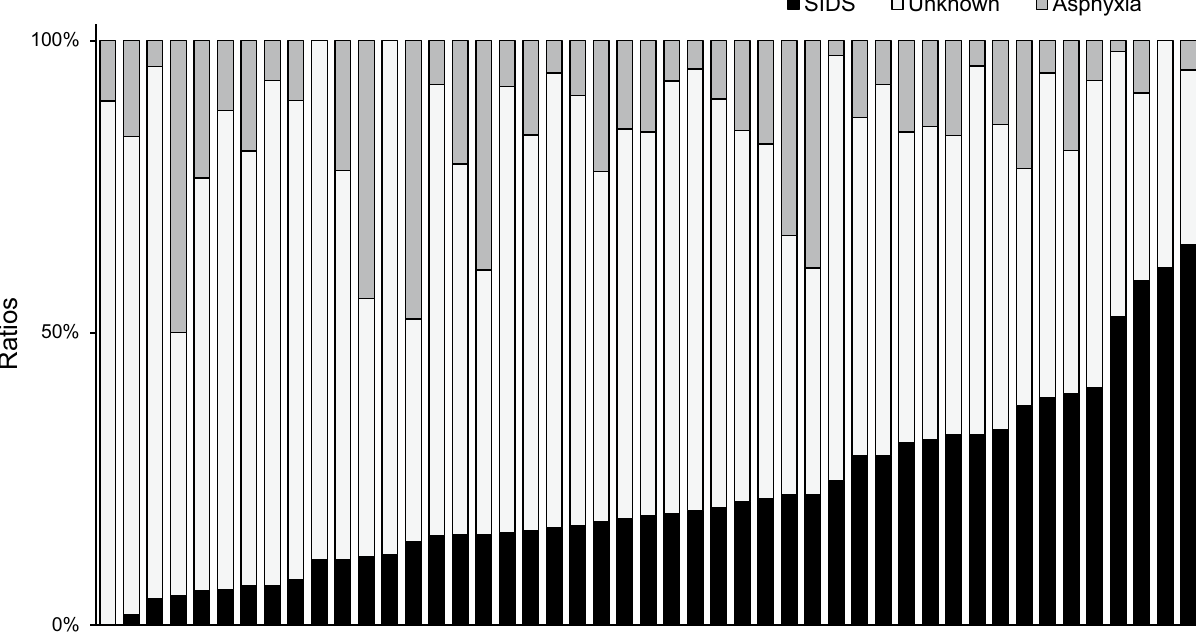
Figure 1. Ratios of sudden unexpected infant death (SUID) subcategories to total SUID cases in the 47 prefectures in Japan from 2012 to 2018. SUID was defined as a set of the following three subcategories: SIDS, accidental asphyxia, and unknown causes of death. SIDS, R95 (SIDS) in ICD-10; accidental asphyxia, the combination of W75 (accidental suffocation and strangulation in bed), W78 (inhalation of gastric contents), and W79 (inhalation and ingestion of food, causing obstruction of respiratory tract); unknown causes of death, the combination of R96 (other sudden death, cause unknown), R98 (unattended death), and R99 (other ill-defined and unspecified causes of mortality). SUID, sudden unexpected infant death; ICD-10, International Classification of Diseases, 10th Revision; SIDS, sudden infant death syndrome.